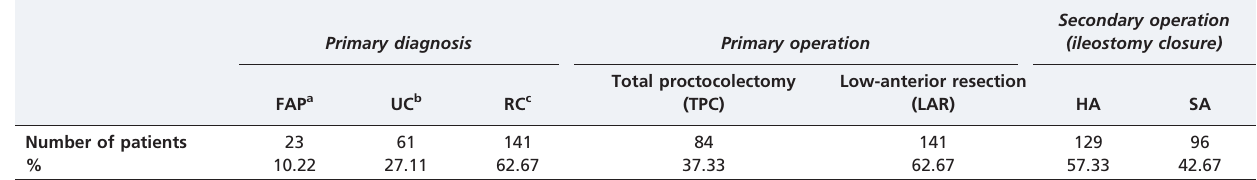
Table 1 - The distribution of the patients according to their diagnoses and surgical interventions.